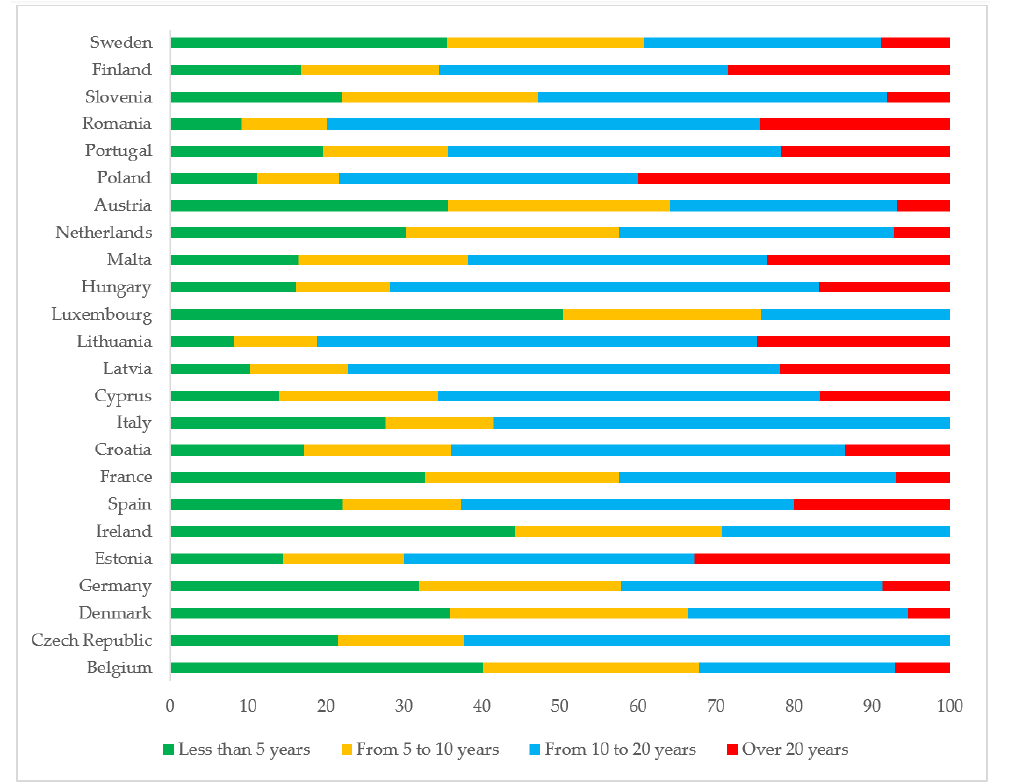
Figure 5. Passenger cars by age in EU countries in 2020, %. Note: the data for Bulgaria, Greece and Slovakia are not available. Source: [74].